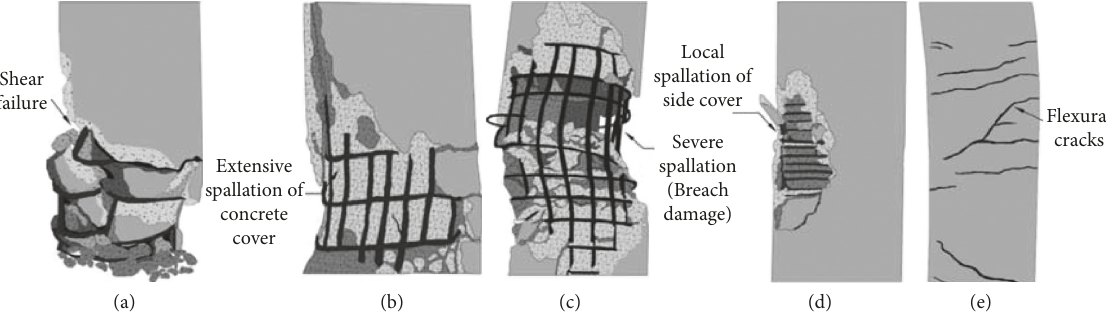
Figure 7: Typical failure modes of RC bridge column under blast load [6]: (a) brittle shear failure; (b) medium spall damage of concrete cover; (c) severe spall damage; (d) local spall damage of concrete cover; (e) flexural